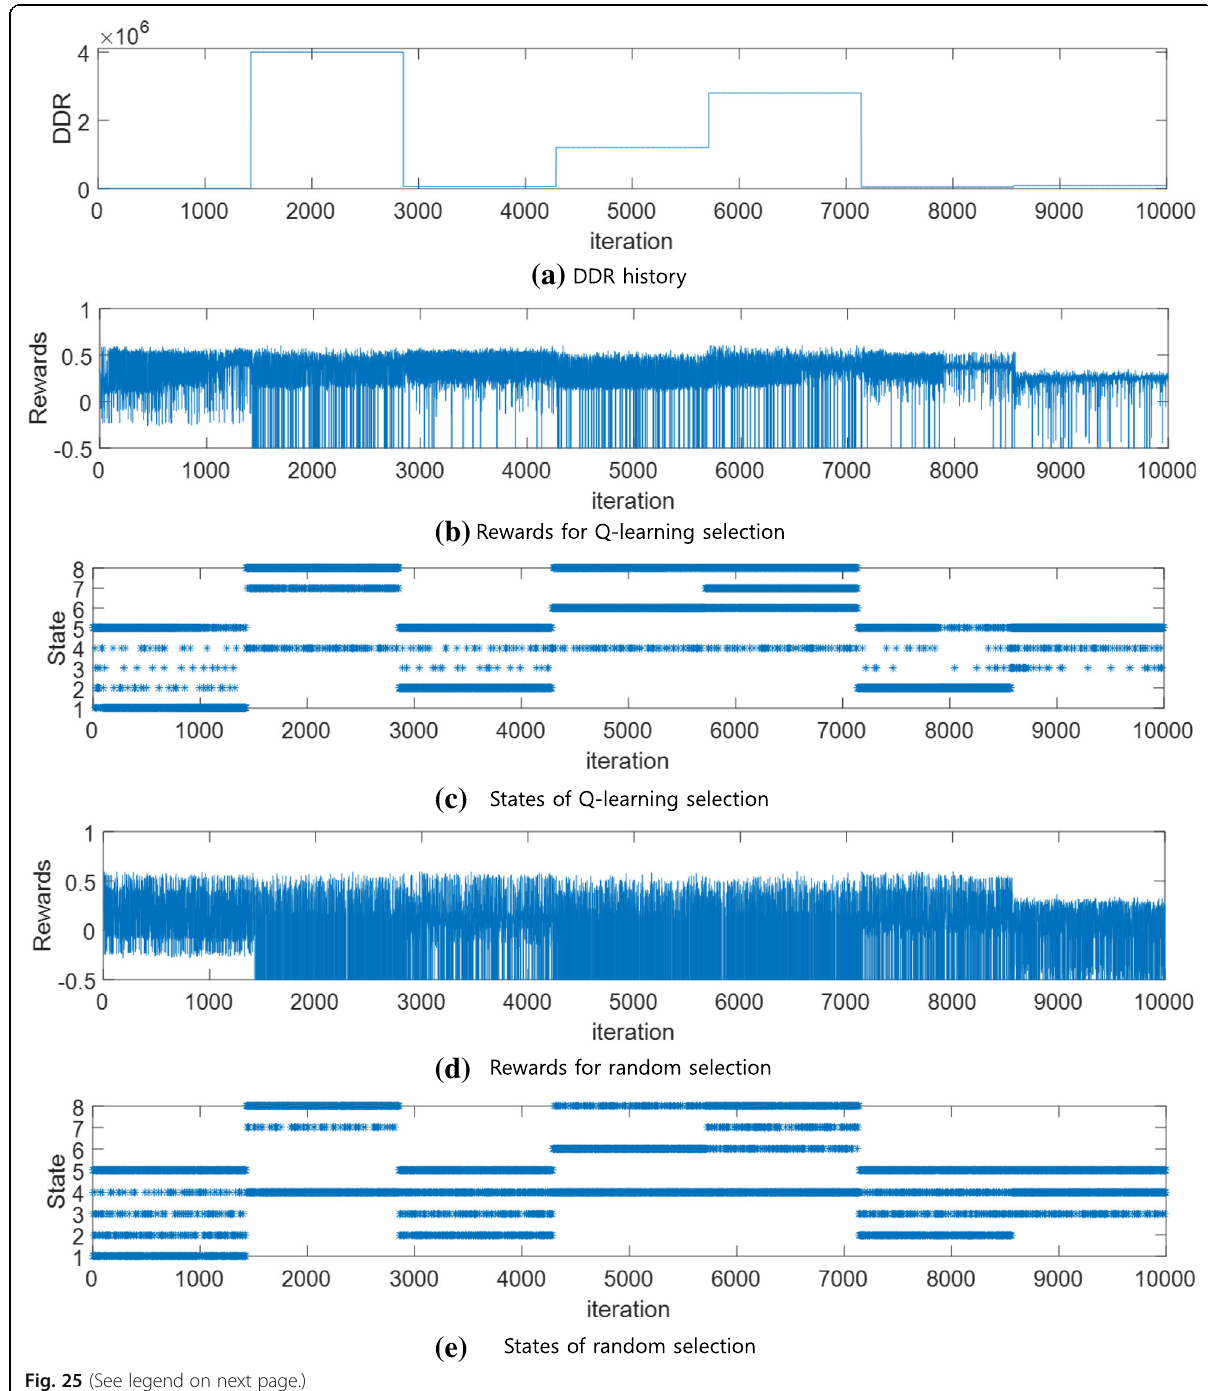
Fig. 25 (See legend on next